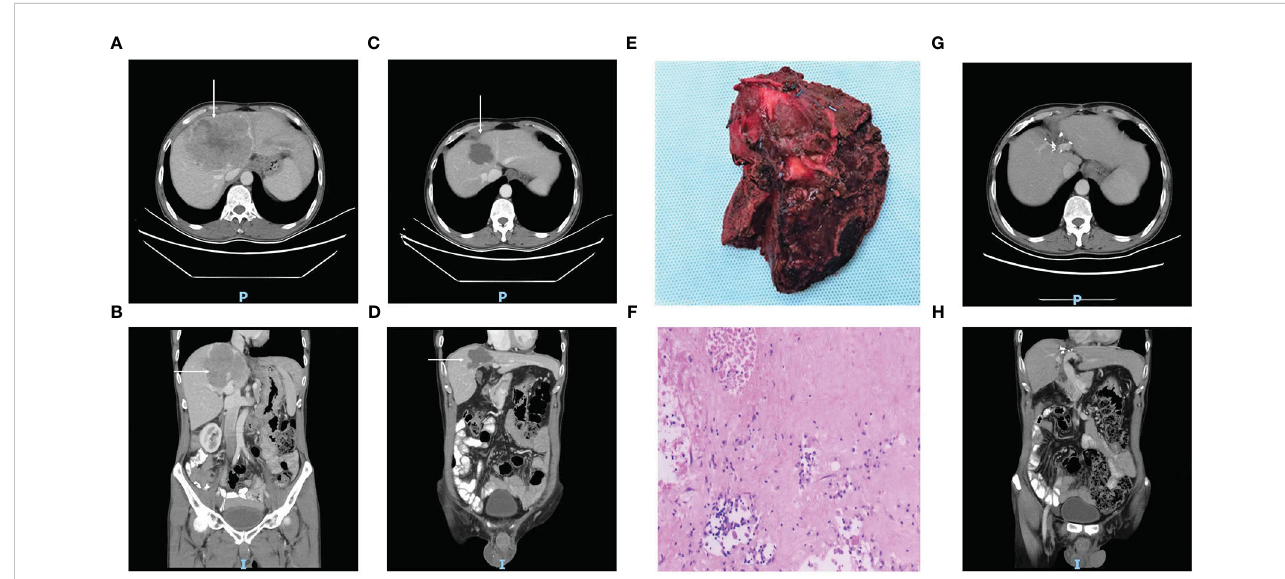
FIGURE 2 Case summary of a typical patient with unresectable HCC, who underwent surgery after conversion therapy with Sintilimab plus Lenvatinib. (A^ – D, G, H) CT images of the axial (A, C, G) and coronal (B, D, H) planes acquired before treatment ( A , B , tumor marked with white arrows), after 9 cycles of Sintilimab plus Lenvatinib ( C , D , tumor shrinkage marked with white arrows), and one year after surgery ( G , H , showing no signs of tumor recurrence). (E) Photograph of the surgical tumor specimen. (F) The pathology fi ndings in the resected specimen, which indicate only 5% around tumor cell